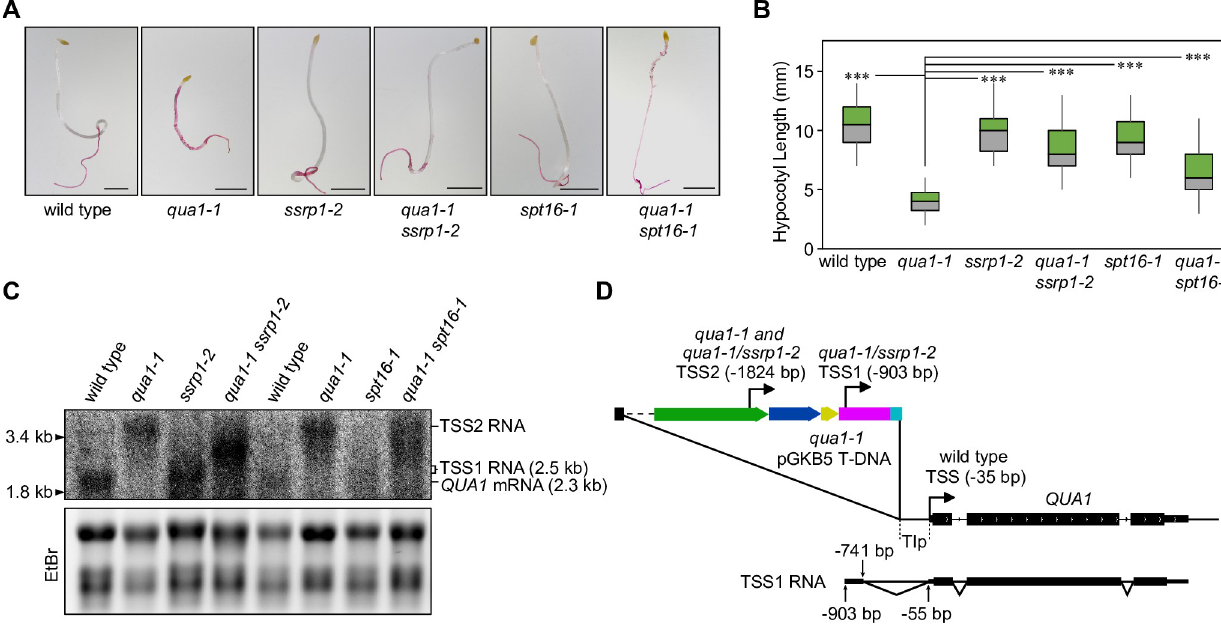
Fig 4. The Arabidopsis FACT complex is required for downstream gene repression through the act of RNAPII transcription. (A) Ruthenium red staining of wild type (WS), qua1-1 , spt16-1 , ssrp1-2 , and double mutants qua1-1/spt16-1 and qua1-1/ssrp1-2 . All scale bars represent 2 mm. (B) Quantification of hypocotyl length (mm) for 7 days, dark-grown wild type (WS), (n = 30), qua1-1 (n = 30), spt16-1 (n = 30), ssrp1-2 (n = 30), and double mutants qua1-1/spt16-1 (n = 30) and qua1-1/ssrp1-2 (n = 30). Three asterisks denote p < 0.001 between qua1-1 and all other samples by Student’s t-test. (C) Analysis of QUA1 transcripts in wild type (WS), qua1-1 , ssrp1-2 , and the qua1-1/ssrp1-2 double mutant as well as in spt16-1 and the qua1-1/spt16-1 double mutant by northern blotting. EtBr staining of ribosomal RNA is used as a control to assess relative equal loading and RNA quality. (D) Schematic representation of the qua1-1 locus with T-DNA insertion (p35s: green, bialaphos resistance gene: blue, terminator: yellow, left border: magenta, polylinker: cyan) including the positions of TSSs mapped by 5’RACE in wild type (WS), qua1-1 , and the qua1-1/ssrp1-2 double mutant. TSS (-35 bp) represents the canonical transcription start site of QUA1 in wild type. TSS2 (-1824 bp) represents the upstream TSS originating from p35s in the T-DNA insertion, shared by qua1-1 and qua1-1/ssrp1-2 double mutant. TSS1 (-903 bp) represents the new TSS in qua1-1/ssrp1-2 . TSS1 results in a novel spliced QUA1 mRNA transcript with a short 5’UTR extension (182 nt) that corresponds to a functional QUA1